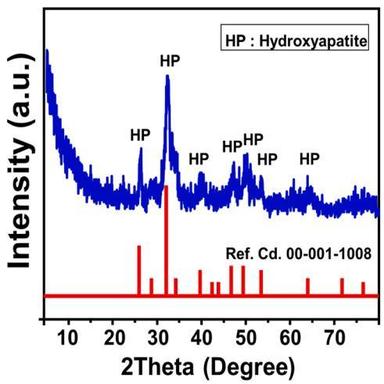
X-ray diffraction pattern of the as-synthesized Mg-doped hydroxyapatite nanofibers.